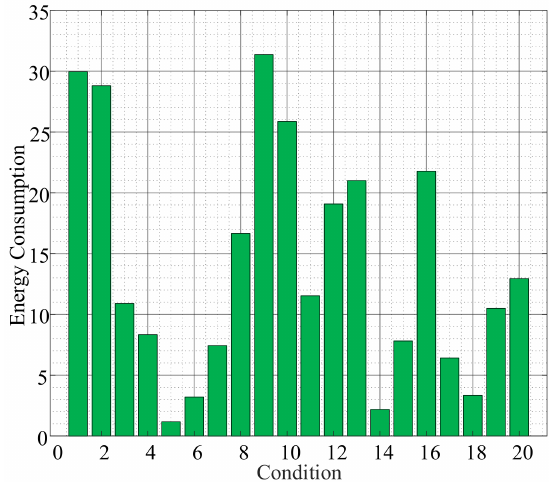
Figure 16. Energy for fifth line condition.